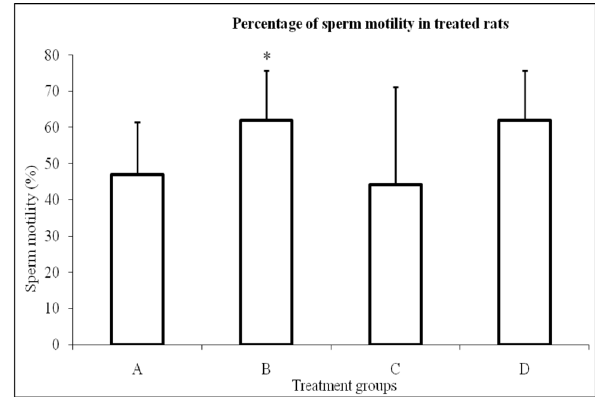
*p < 0.05 as compared to group A (control) Figure 3 - The percentage of motile sperms in rats treated with EL (B), estradiol (C) and a combination of EL and estradiol (D) compared to the control (A). The values are shown as the mean + standard deviation. Group B shows a marked increase in the percentage of motile sperms compared to group